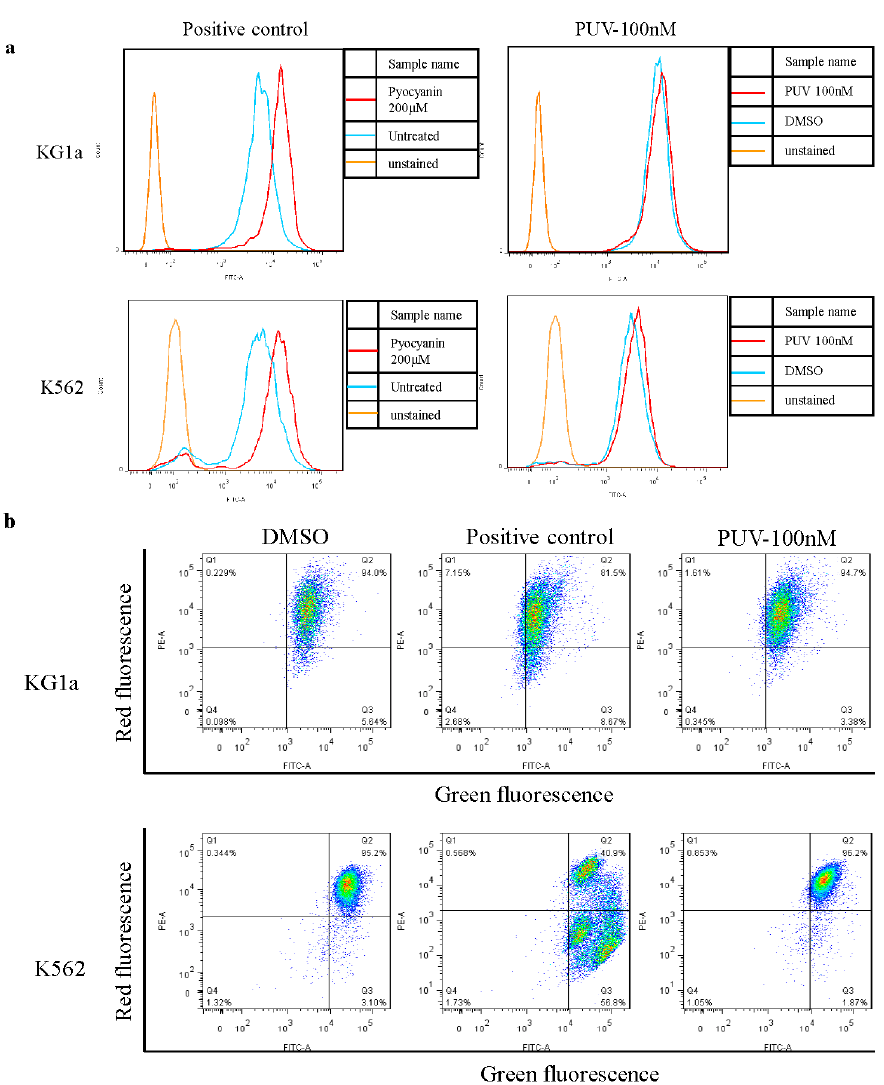
Figure 5. Peruvoside treatment did not alter the intracellular Reactive Oxygen Species (ROS) level nor the loss of MMR in KG1a and K562 cells. ( a ) Both cell lines were treated with 100 nM of Peruvoside or 200 nM of Pyocyanin for 2 h before stained with ROS indicator; ( b ) Both cell lines were treated with a positive control or 100 nM of Peruvoside for 24 h followed by JC-1 staining. Fluorescence signal was measured and analyzed by flow cytometry. PUV: Peruvoside.